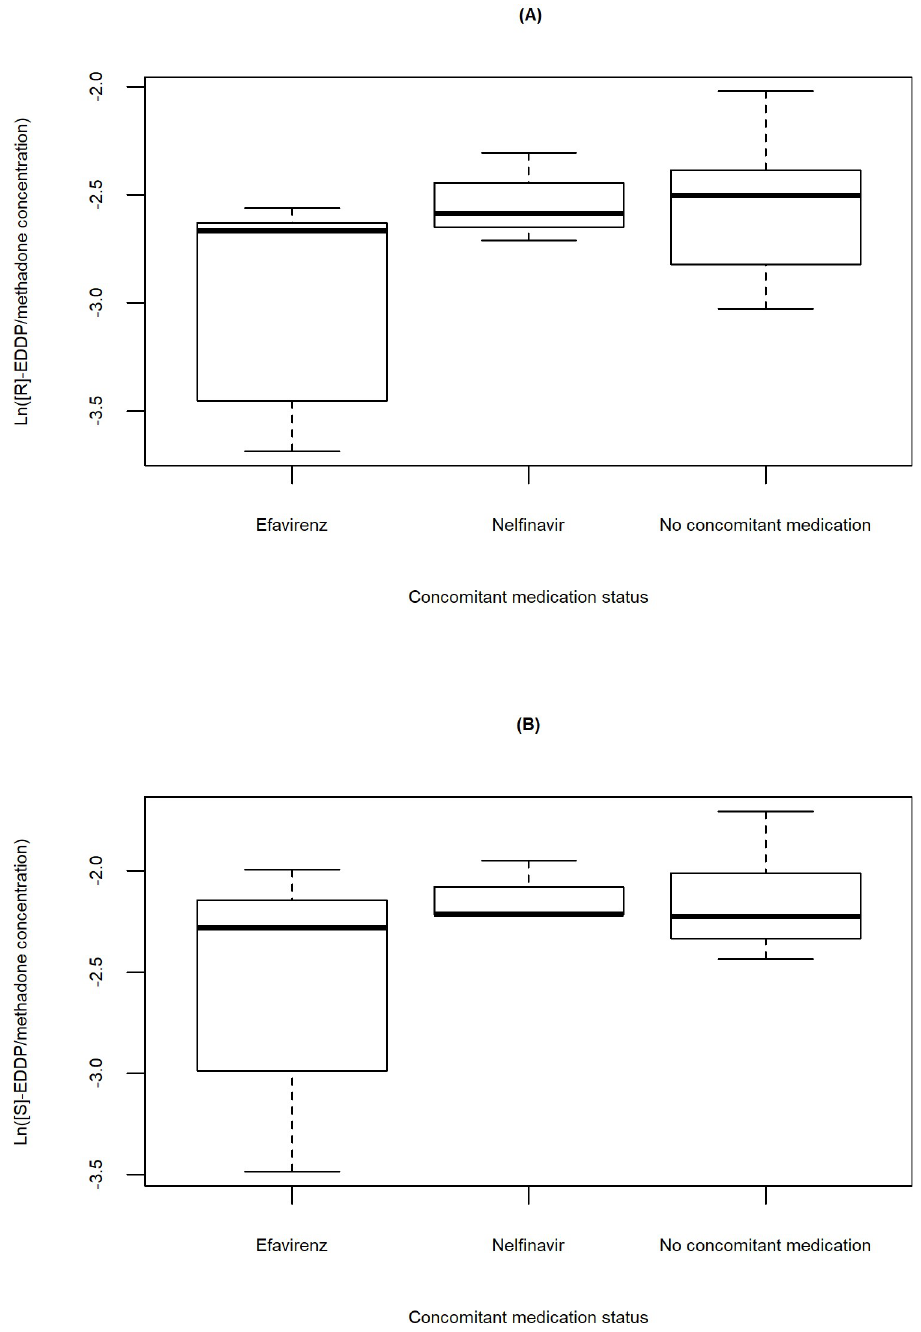
Fig 5. Methadone metabolism stratified by concomitant medication status. Boxplots of (A) ln (R)- and (B) ln (S)- EDDP/methadone concentration versus CYP2B6 inducer or no concomitant medication for HCV/HIV co-infected participants. Most of the participants who took CYP2B6 inducer medications were HCV/HIV co-infected. The lower ln([R]-EDDP/methadone concentration) and ln([S]-EDDP/methadone concentration) values are largely driven by